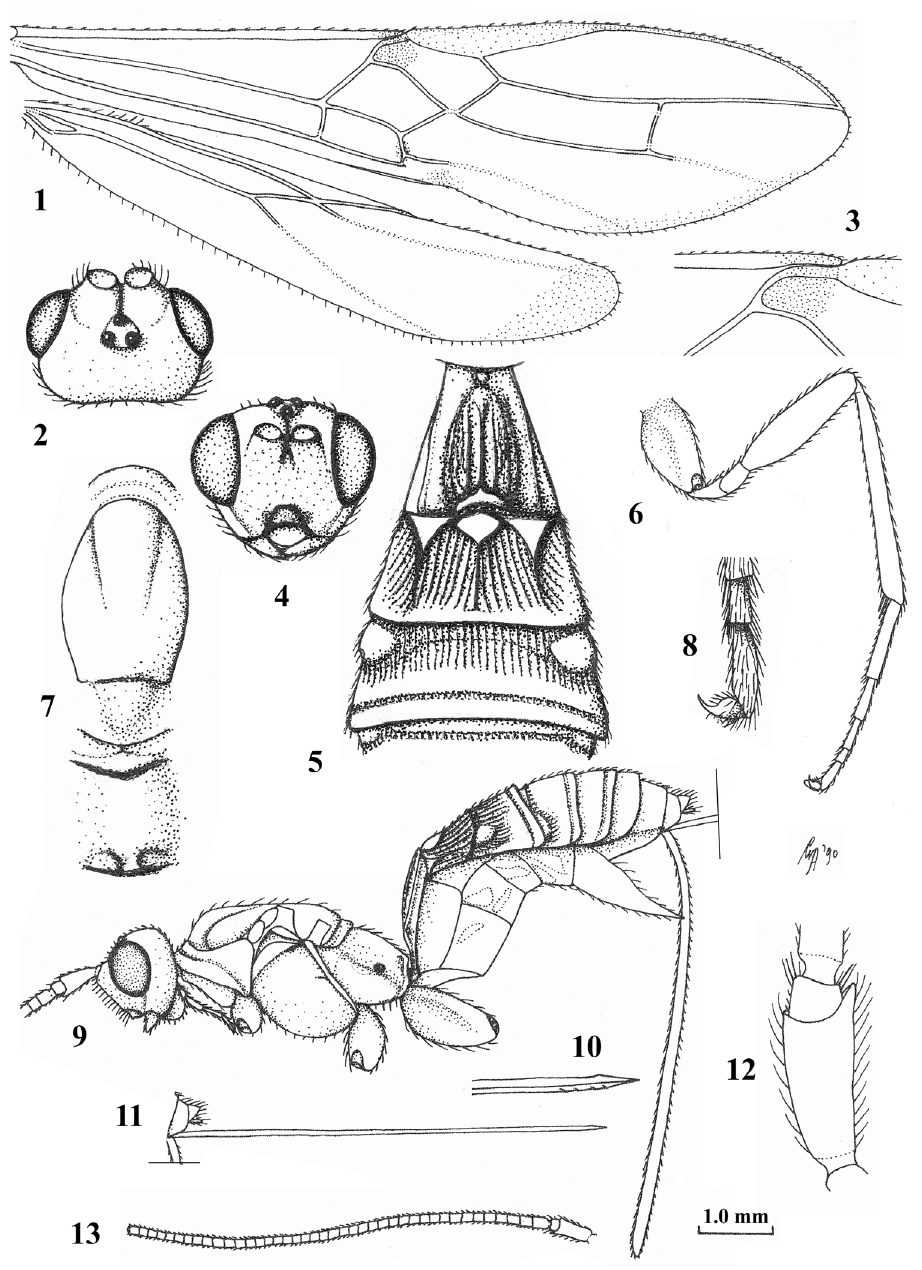
Figures 1–13. Craspedolcus trisulcatus Enderlein, ♀ , lectotype. 1 wings 2 head dorsal 3 detail of vein 1-SR of fore wing 4 head anterior 5 first–third metasomal tergites dorsal 6 hind leg lateral 7 mesosoma dorsal 8 , outer hind claw lateral 9 habitus lateral 10 apex of ovipositor lateral 11 ovipositor 12 scapus outer side lateral 13 antenna lateral. 1, 6, 9, 11, 13 : scale-line (= 1 ×); 2–5, 7 : 2 ×; 8, 10, 12 : 5